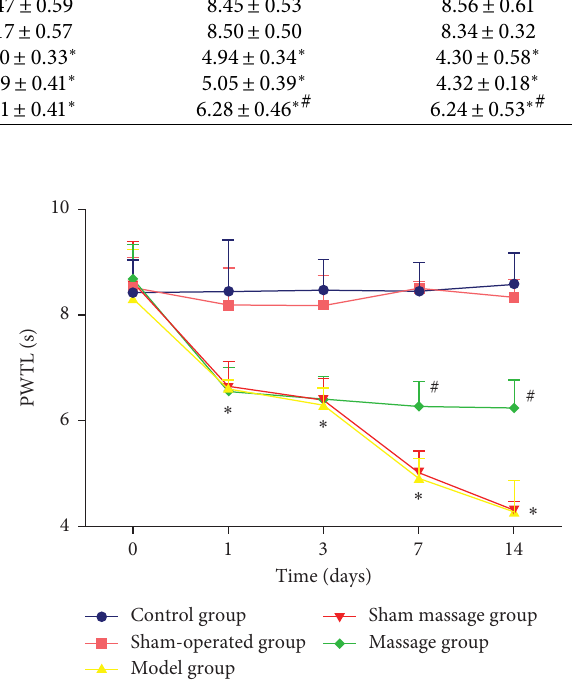
Figure 2: PWTLs of the groups 1 day, 3 days, 7 days, and 14 days after surgery. ∗ P < 0 . 05 compared with the control group; # P < 0 . 05 compared with the model